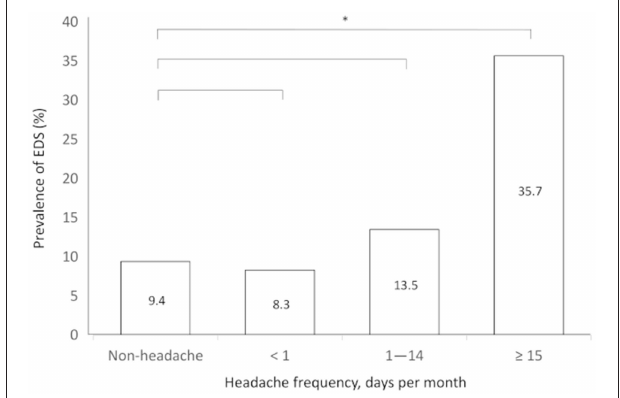
FIGURE 2 | Prevalence of excessive daytime sleepiness according to the frequency of tension-type headache. * p < 0.05.